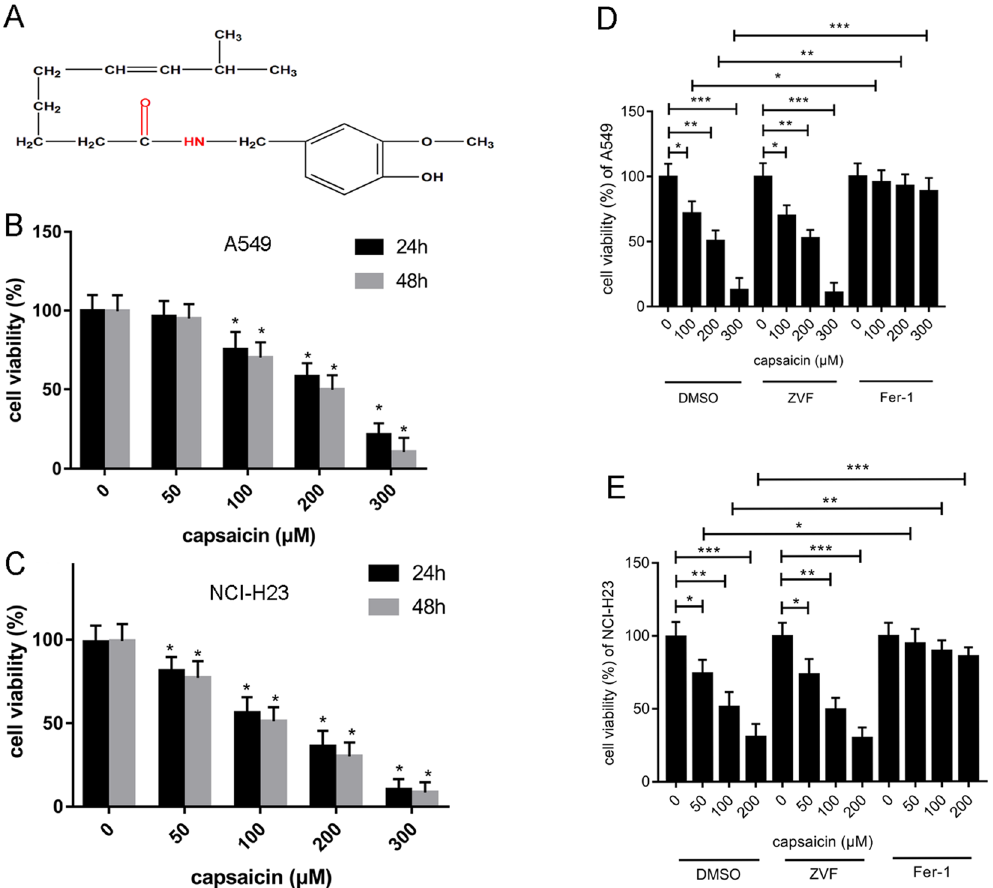
Figure 1. Capsaicin induced ferroptosis of A549 and NCI-H23 cells. ( A ) The chemical formula of capsaicin. ( B and C ) The cell viabilities of A549 and NCI-H23 cells which were treated by capsaicin (0 μM, 50 μM, 100 μM, 200 μM and 300 μM) were detected by MTT assay. ( D and E ) The cell viability of A549 and NCI-H23 cells which were treated with capsaicin and ZVF (Z-VAD-FMK, 100 μM)/Fer-1 (Ferrostatin-1, 1 μM) were analyzed by MTT assay. The experiments were repeated thrice. (* P < 0.05, ** P < 0.01, *** P <